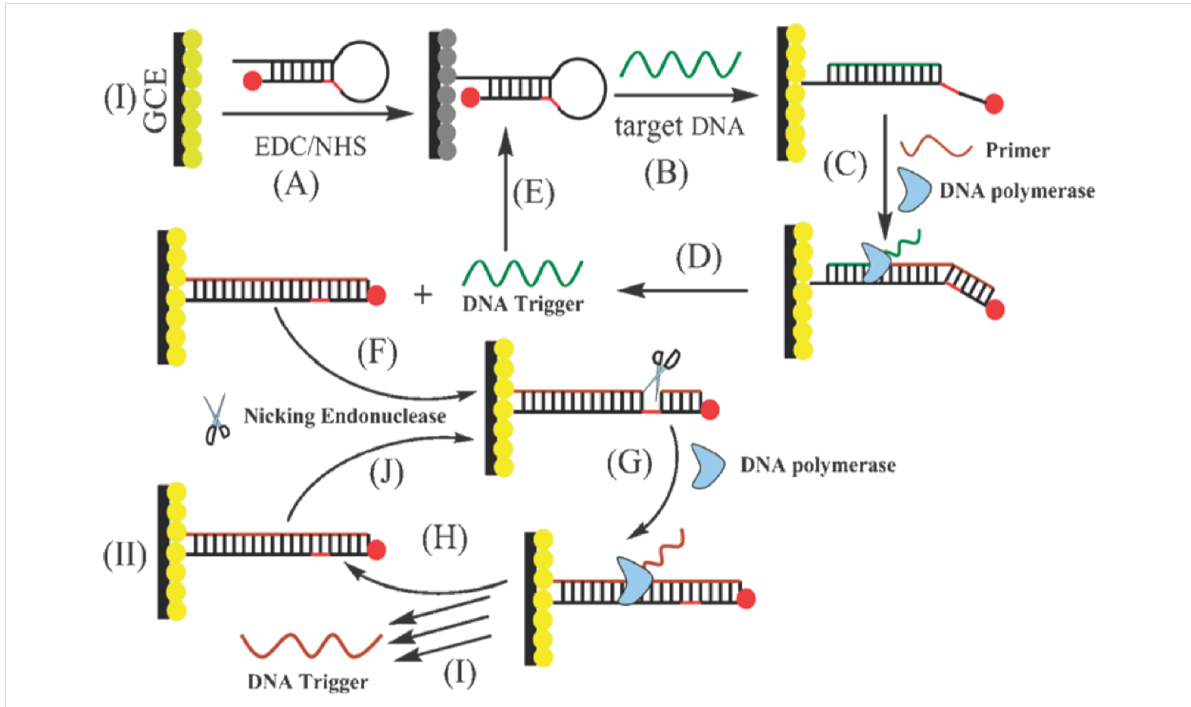
Figure 11: The use of gold nanoparticles as fluorescence quencher in the discrimination of SNP through cyclic enzyme-aided polymerization and nicking of oligonucleotides. The presence of a mutation decreases the fluorescence of the CdS films by nearly 90%. Reprinted with permission from [121], copyright 2011 Royal Society of Chemistry.